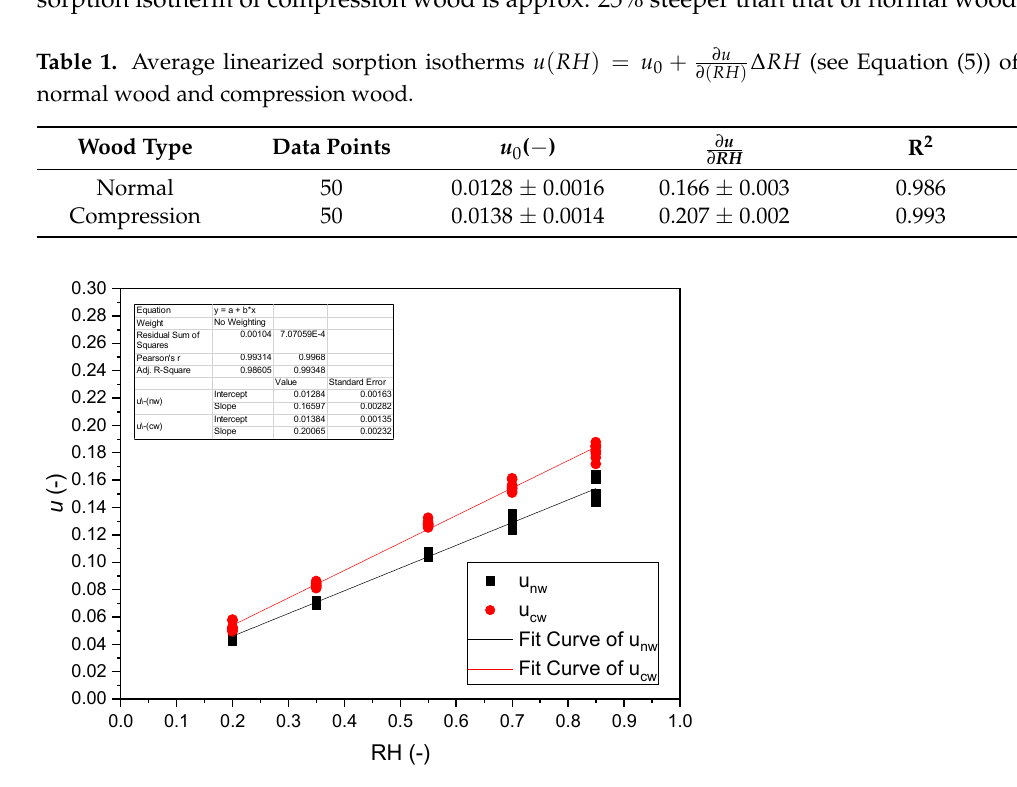
Figure 1. Sorption Isotherms of normal (squares) and compression wood (circles) of reference strips.